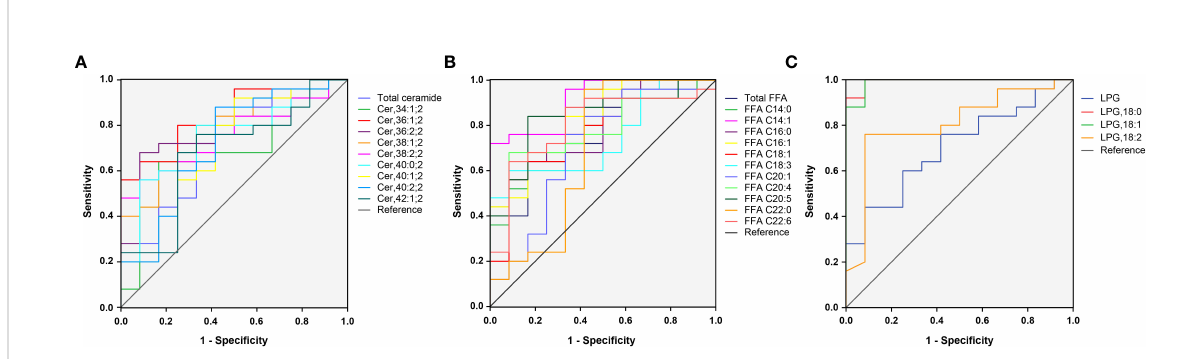
FIGURE 3 ROC curves for 23 selected lipid subclasses for differentiating women with PCOS from normal healthy individuals. The AUC value of Cer,36:1;2, FFA C14:1, and LPG,18:0 was larger than that of the total ceramide (A) , total FFA (B) , and LPG (C) ,